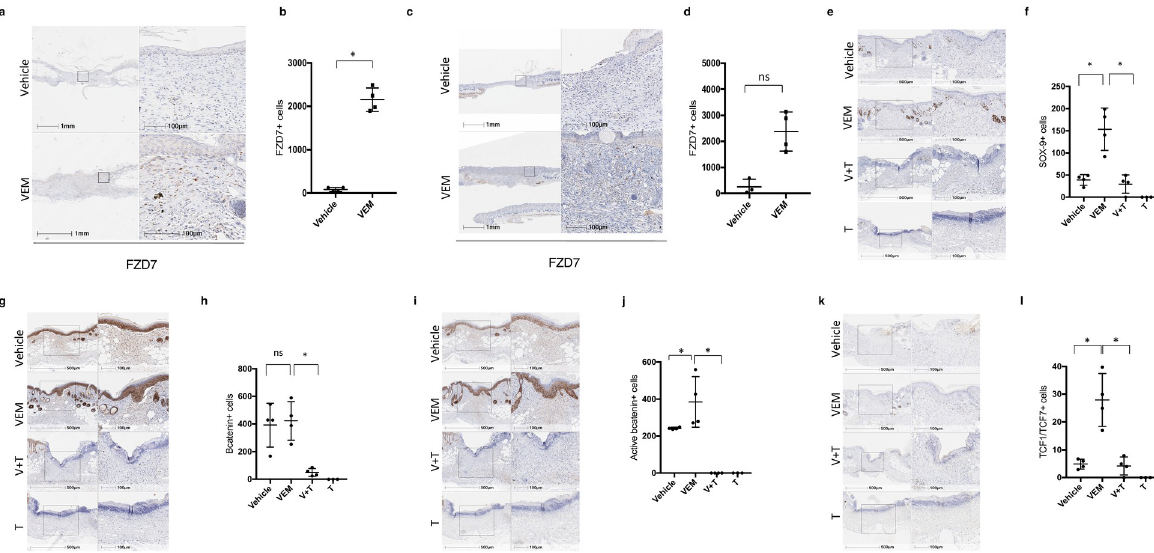
Fig 5. Topical vemurafenib enhances FZD7 and promotes β -catenin signaling which is reversed by MEK inhibition. (a and c) Representative FZD7 staining IHC images in the presence and absence of vemurafenib in (a) db/db mice and (c) Balb/c wounds by day 16. (b and d) Scatter plots representing the quantification of FZD7+ cells ( � P = 0.02, n = 4) for control wounds versus treated db/db (b) and Balb/c wounds (d) on day 16. (e) Representative images of Sox-9 IHC staining of vehicle-, vemurafenib-, vemurafenib plus trametinib (T), trametinib alone (T) treated C3H wounds on day 6 (f) Scatter plots representing the quantification of SOX-9+ cells (P = 0.02; Vehicle vs vemurafenib and vemurafenib vs V+T, n = 4) for control wounds versus treated C3H wounds on day 6. (g) Representative images of β -catenin IHC staining of vehicle-, vemurafenib-, vemurafenib plus trametinib (V+T), trametinib alone (T)- treated C3H wounds on day 6. (h) Scatter plots representing the quantification of β -catenin+ cells ( � P = 0.02, vemurafenib vs V+T, n = 4; ns, vehicle vs vemurafenib and vemurafenib vs T) for control wounds versus treated C3H wounds on day 6. (i) Representative images of active β -catenin IHC staining of vehicle-, vemurafenib-, vemurafenib plus trametinib (V+T), trametinib alone (T)- treated C3H wounds on day 6. (j) Scatter plots representing the quantification of active β -catenin + cells ( � P = 0.02; Vehicle vs vemurafenib and vemurafenib vs V+T; n = 4) for control wounds versus treated C3H wounds on day 6. (k) Representative images of TCF1/TCF7 IHC staining of vehicle-, vemurafenib-, vemurafenib plus trametinib (T), trametinib (T)- treated wounds on day 6. (l) Scatter plots representing the quantification of TCF1/TCF7+ cells ( � P = 0.02; vehicle vs vemurafenib and vemurafenib vs V+T; n = 4) for control wounds versus treated C3H wounds on day 6. Error bars in b, d, f, h, j and l mean ± s.d. Bar graphs represent one experiment with 3–4 replicates per